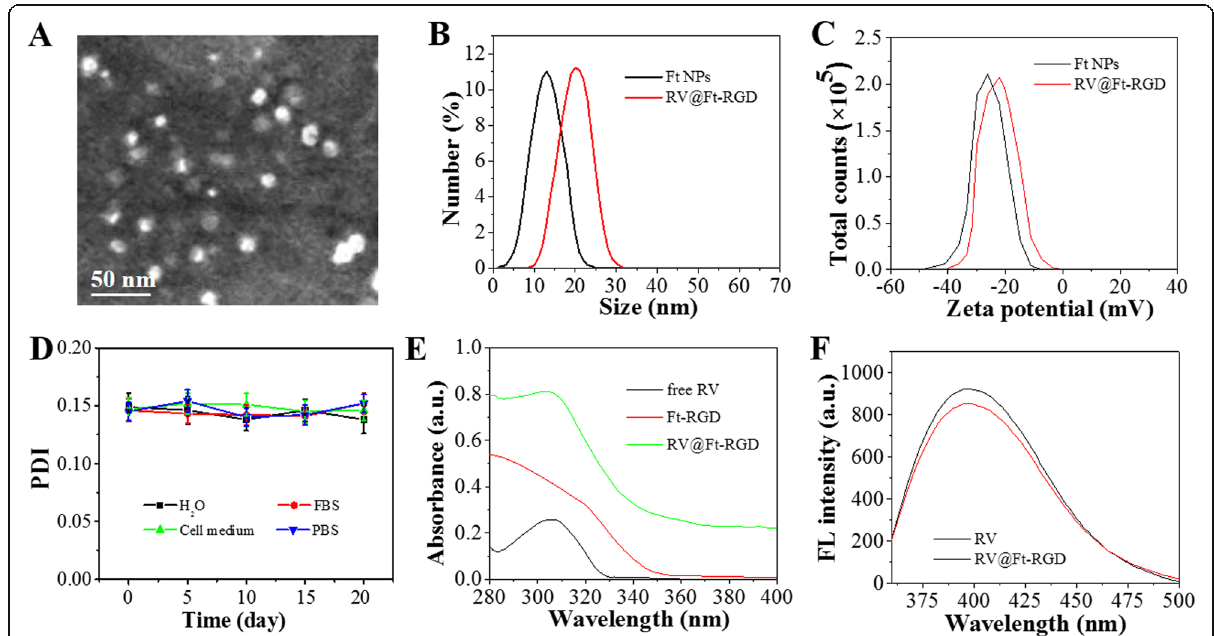
Fig. 2 a The TEM image of RV@Ft-RGD. b , c The size distribution and zeta potential distribution of Ft-RGD and RV@Ft-RGD. d The PDI change of the RV@Ft-RGD in water, FBS, cell medium, and PBS over 20 days. e The absorbance spectra of free RV, Ft-RGD, and RV@Ft-RGD. f The absorbance spectra of free RV and RV@Ft-RGD